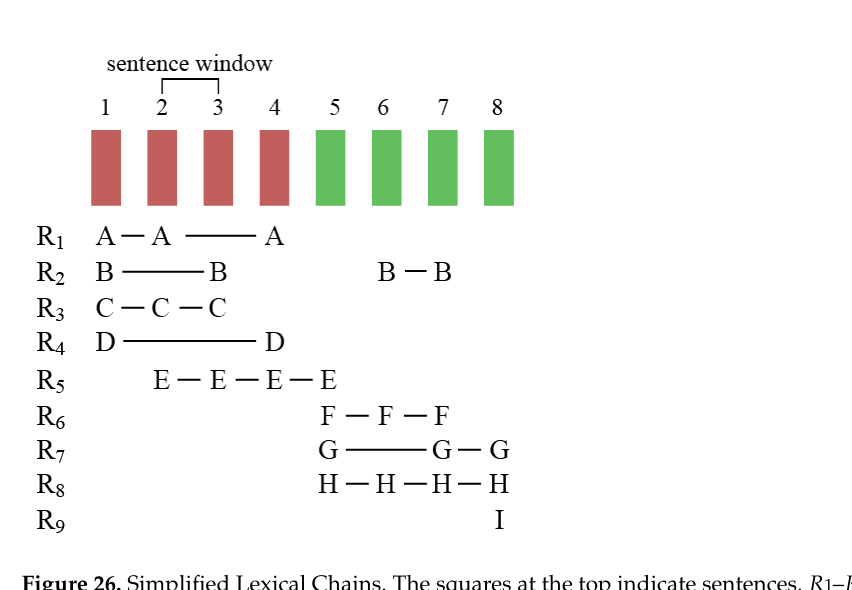
Figure 26. Simplified Lexical Chains. The squares at the top indicate sentences. R 1 – R 9 represent the lexical chains for each word A to